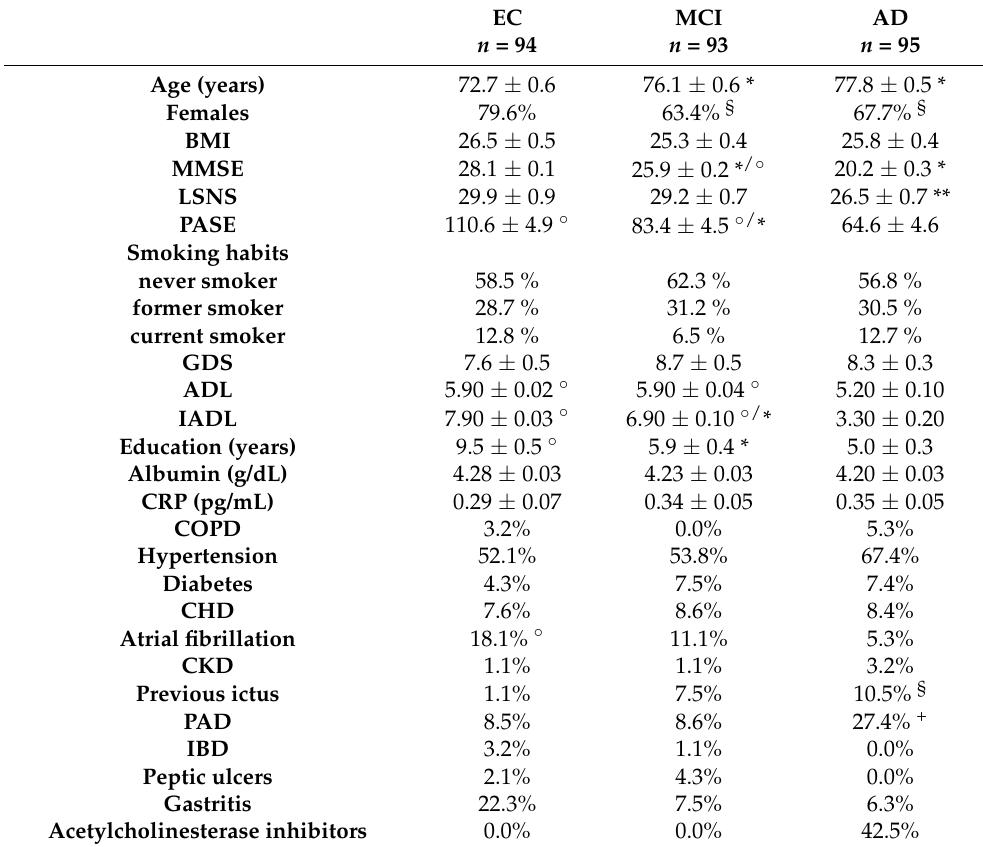
Table 1. Characteristics of elderly controls (EC), mild cognitive impairment (MCI), and Alzheimer’s disease (AD)